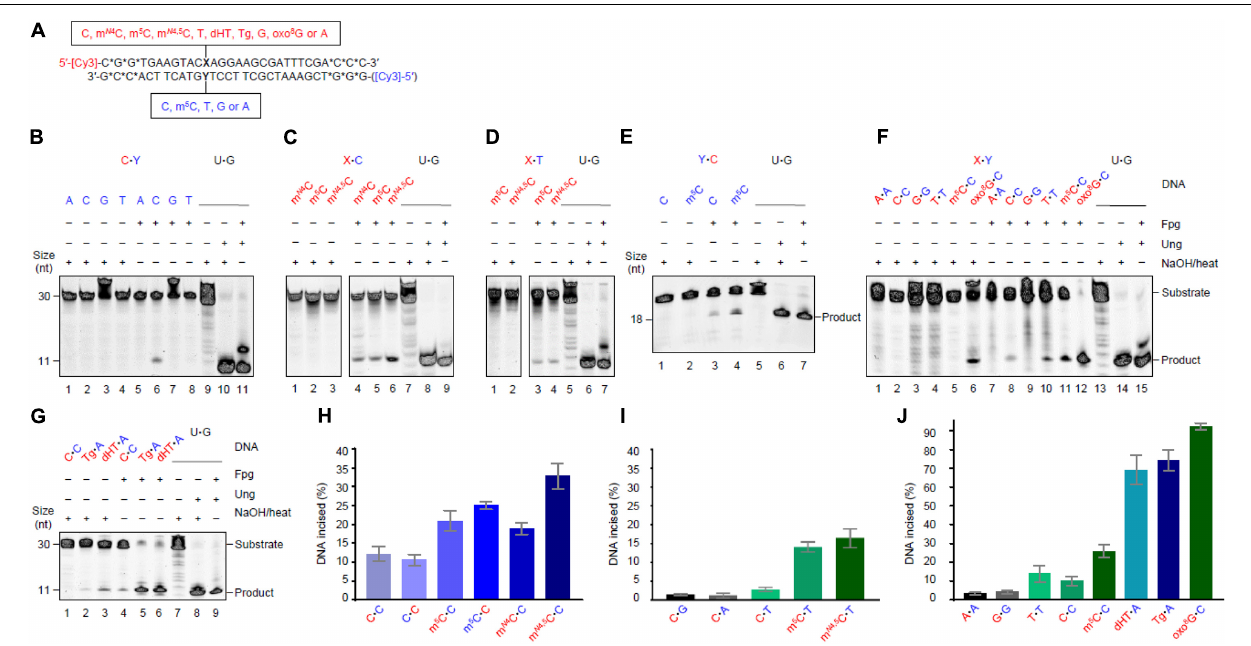
FIGURE 1 | Escherichia coli Fpg protein incises at unmethylated and methylated cytosine when placed opposite C and T in DNA. (A) Schematic representation of DNA substrates. Fluorescently labeled DNA oligonucleotides (*, phosphodiester bonds protected by phosphorothioate) had a spectrum of different studied bases at one site, as indicated. The upper strand was primarily labeled, its variable base defined by X (indicated in red); the lower strand was occasionally labeled, its variable base defined by Y (indicated in blue). The color code is kept throughout all the subsequent figures and tables indicating which variables in which strand were tested in a particular experiment. A variable base in the labeled strand (the assessed one) is always written as the first in a base pair. See Supplementary Figure 1 for an outline of the assay. (B) Activity for C opposite all major bases. (C) Activity for methylated Cs opposite C. (D) Activity for methylated Cs opposite T. In panels (B–D) , DNA (upper strand labeled) X substrate [see panel (A) , 1 pmol] was incubated alone (lanes 1–4) or with Fpg (13 pmol; lanes 5–8) at 37 ◦ C in NEB1 buffer (10 mM Bis–Tris-propane-HCl, pH 7.0, 10 mM MgCl 2 ), 1 mM DTT, 0.1 mg/mL BSA for 1 h. U · G-DNA (30 nt; 1 pmol) was incubated without (lane 9) or with Ung (1.95 pmol; lane 10) followed by NaOH/heat treatment, and was used as a negative and positive control, respectively, for active Ung, and to convert U · G-DNA into AP-DNA to demonstrate active Fpg (i.e., AP lyase activity; lane 11). (E) Activity for C and m 5 C opposite C, when the lower strand with the Y variable was labeled. DNA substrate (1 pmol) was incubated alone (lanes 1 and 2) or with Fpg (lanes 3 and 4) using the controls (lanes 5–7) described above. (F) Activity for C, m 5 C, or oxo 8 G opposite C compared to the other homo-mismatches. (G) Activity for C opposite C compared to Tg and dHT opposite A. In panels (F,G) , DNA (upper strand labeled) X substrate [see panel (A) , 1 pmol] was incubated alone (lanes 1–6 and 1–3, respectively) or with Fpg (lanes 7–12 and 4–6, respectively) using the controls (lanes 13–15 and 7–9, respectively) described above. (H) The percent of the labeled strand incised at unmethylated and methylated C opposite C. (I) The percent of the labeled strand incised at unmethylated C opposite T, A, or G compared to methylated C opposite T. (J) The percent of the labeled strand incised at most homo-mismatches compared to oxidized bases in DNA. These column graphs show the average values ( ± SD) obtained from 4 to 10 independent experiments as presented in panels (B–G) , the first base in each pair being the one